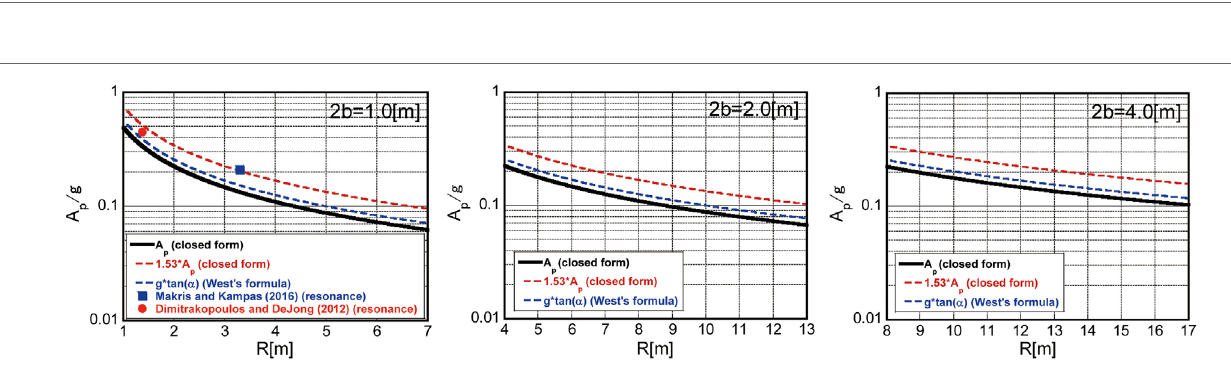
FigUre 9 | critical timing with respect to R for 2 b = 1, 2, and 4 m (closed-form expression for linearized model and numerical simulation for non-linear model)